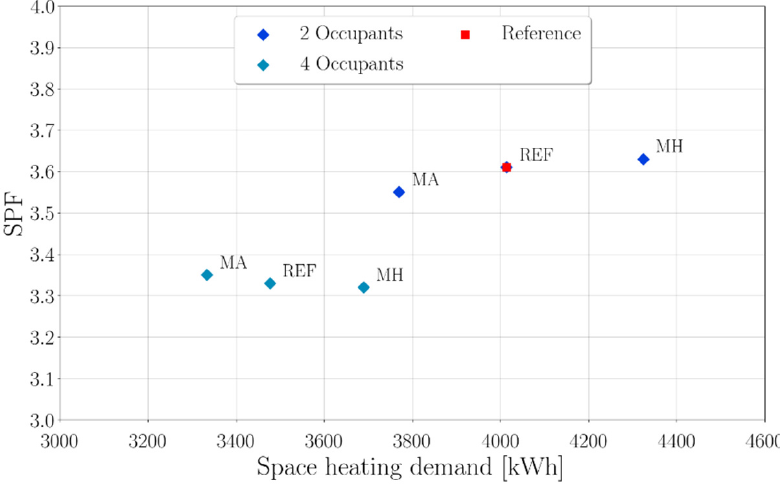
Figure 25. SPF versus the space heating demand for different number of occupants, two or four, and three different occupancy profiles: Reference (REF), Mostly at Home (MH), and Mostly Away (MA). Note that the corresponding DHW demand for a respective two and four-person household are 6 and 12 GJ.